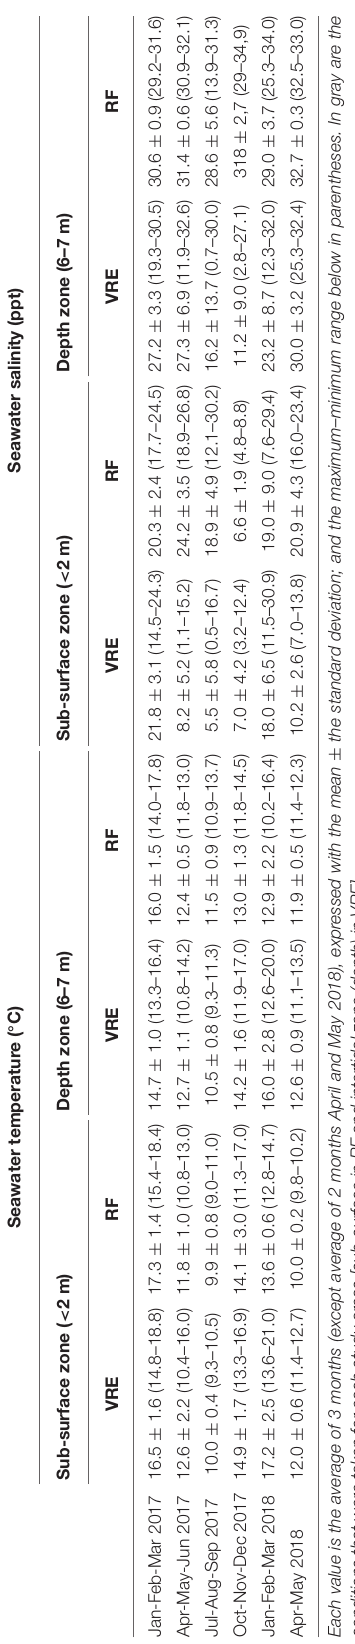
( Figure 2 ). The best fitted GLMM for the association between the total count of mauve-purple colonies in the CHROMagar culture and predictive factors ( Table 3 ) showed a similar pattern than the total count of the vibrio colonies model. The Valdivia River Estuary area presented a significantly higher count than the Reloncaví Fjord, and water temperature was positively associated with this response variable. However, salinity was negatively associated with the count of mauve-purple colonies. In addition, when a stratified analysis of the presumptive V. parahaemolyticus by area was performed, statistical differences were observed between points ( P < 0.001), where in the Valdivia River Estuary point 1 presented a significantly higher presumptive V. parahaemolyticus count than points 2 and 3. Points 6 and 7 in the Reloncaví Fjord had a significantly lower presumptive V. parahaemolyticus count than point 4. Additionally, the interaction between area and temperature was significant, showing that during warm months the area effect is reversed, because the Valdivia River Estuary presented lower counts than the Reloncaví Fjord. This means that a higher count of mauve-purple colonies is expected in the Valdivia River Estuary over the year, but during the summer the risk of finding mauve-purple colonies in mussels increases significantly in the Reloncaví Fjord area. Other factors and interactions assessed were not